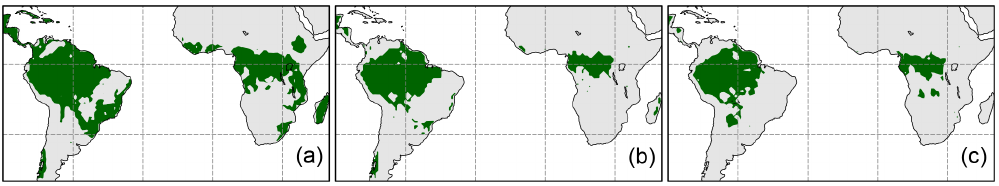
Figure 2. Tree dominated areas of the (a) unchanged large-scale disturbance experiment, (b) parameter-updated experiment, and (c)